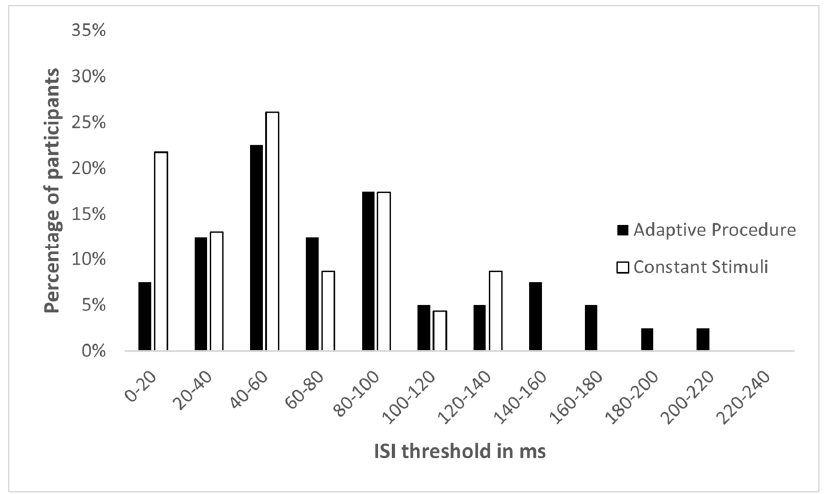
Figure 3. Threshold distribution for spectral TOJ in adaptive procedure and method of constant